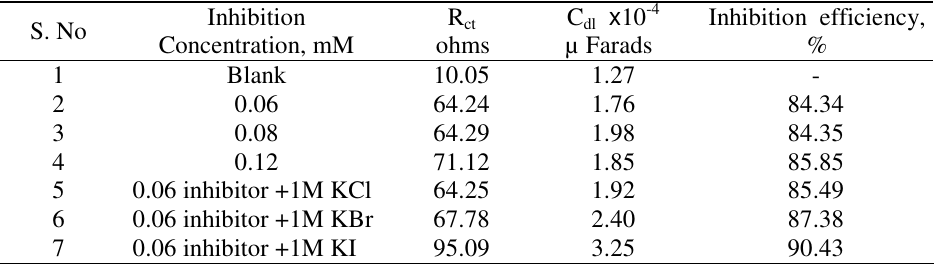
Table 8. Impedance parameters for the corrosion of mild steel in 1 M H without (02TD).